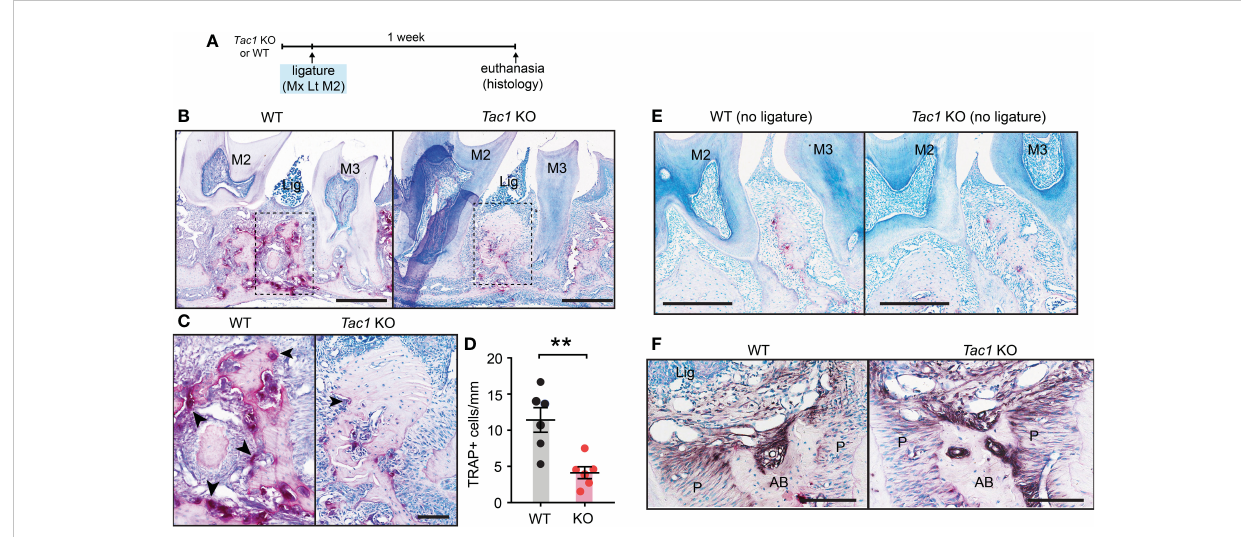
FIGURE 4 Knockout of Tac1 reduces ligature-induced activation of osteoclasts. (A) Time course of the experiments. (B) TRAP staining fi ve days after ligature placement in Tac1 KO and WT mice. Lig, ligature; M2, second molar; M3, third molar. Scale bar, 500µm. (C) Magni fi ed view of the insets in (A) Scale bar, 100µm. (D) Quanti fi cation of TRAP+ cells. **p < 0.01 in Student ’ s t-tests. N=6 per group. (E) TRAP staining of periodontia without ligature in WT and Tac1 KO mice. Scale bar, 200µm. (F) Alkaline phosphatase staining in Tac1 KO and WT mice. Scale bar, 100µm. AB, alveolar bone; Lig, ligature; P, periodontal ligament.